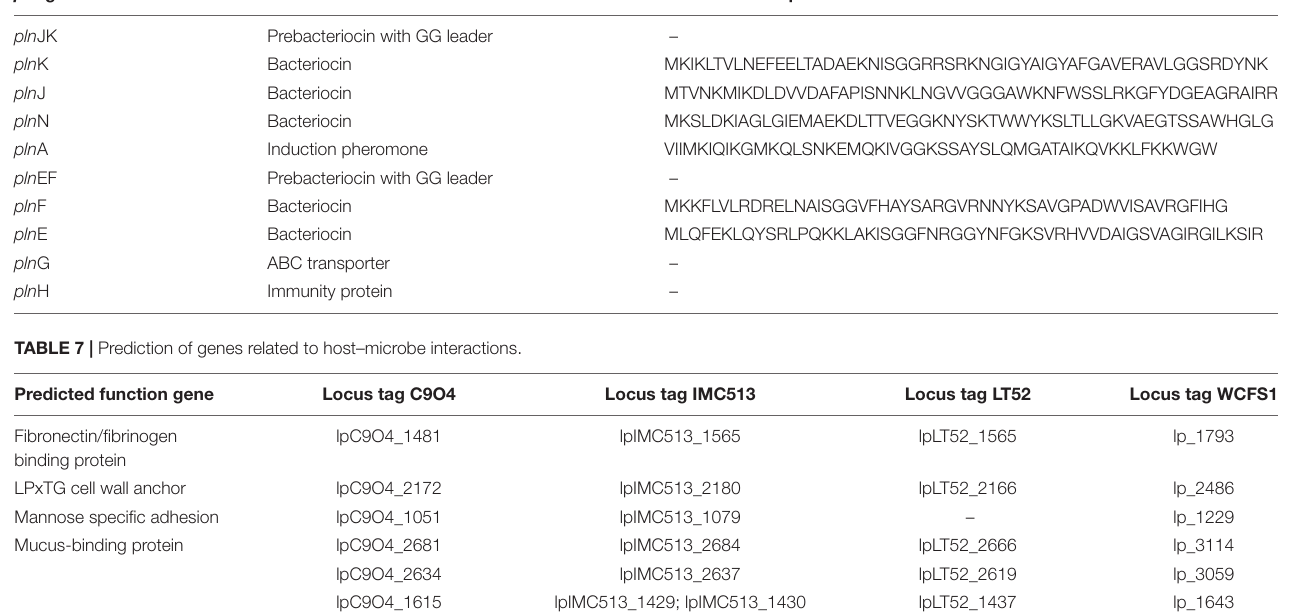
TABLE 6 | Amino acid sequence of the plantaricin encoding genes belonging to the pln locus. pln genes Function Amino acid sequence pln JK